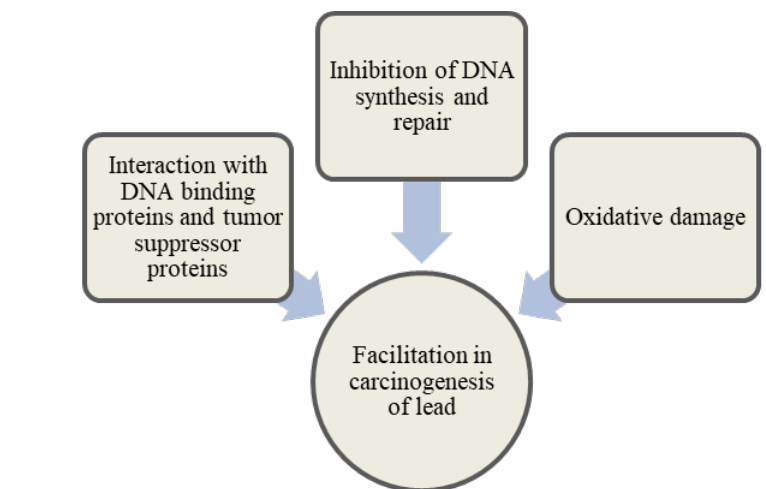
Figure 2. The facilitative roles of lead in carcinogenesis Figure 2: The Facilitative Roles of Lead in